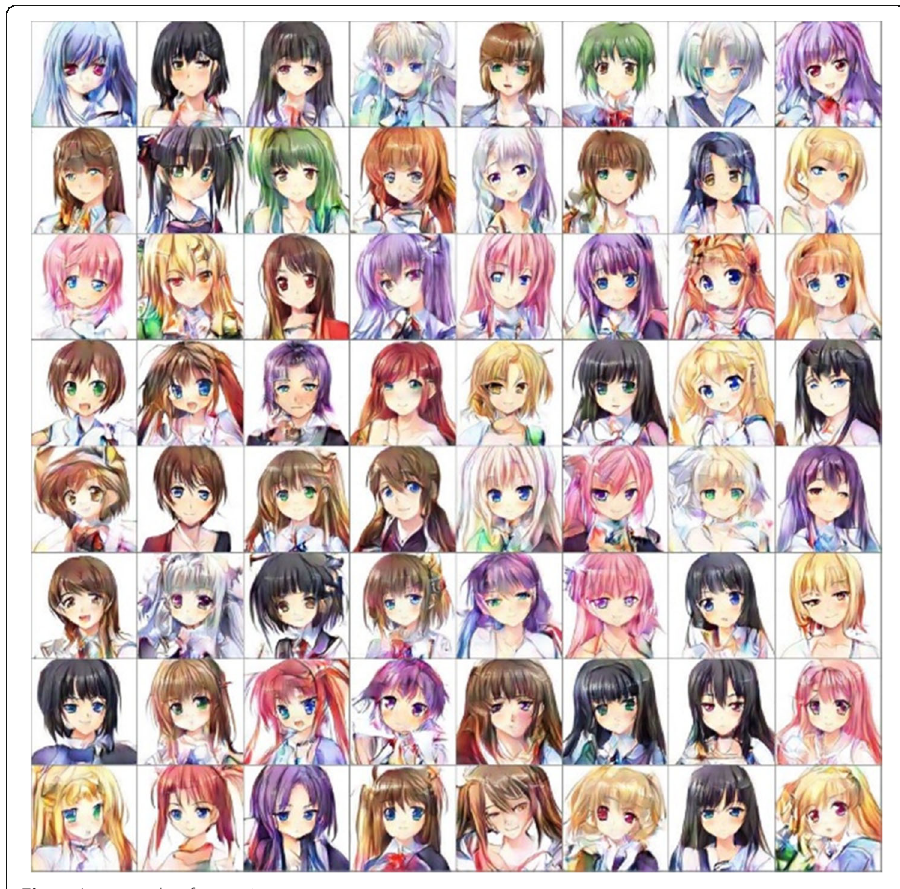
Fig. 7 An example of